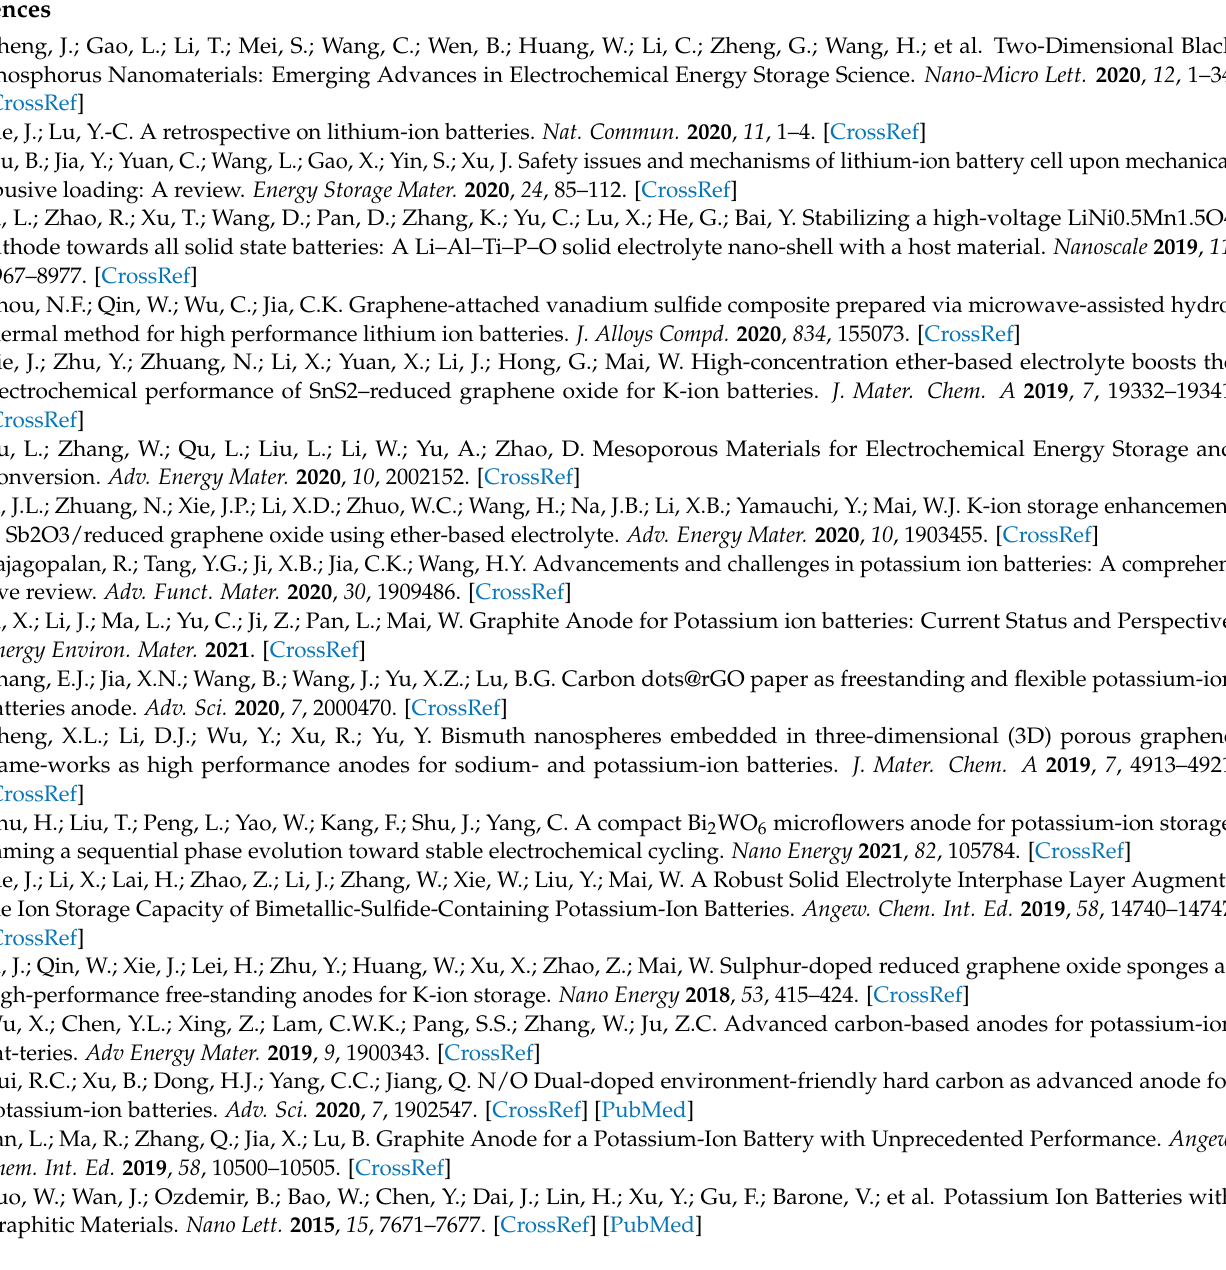
Figure S2: (a) nitrogen adsorption-desorption isotherms and (b) pore diameter distribution of CNF and N-CNF; Figure S3: CEs of CNF and N-CNF; Figure S4: EIS of CNF and N-CNF after 50 cycles; Table S1: The obtained parameters based on DFT